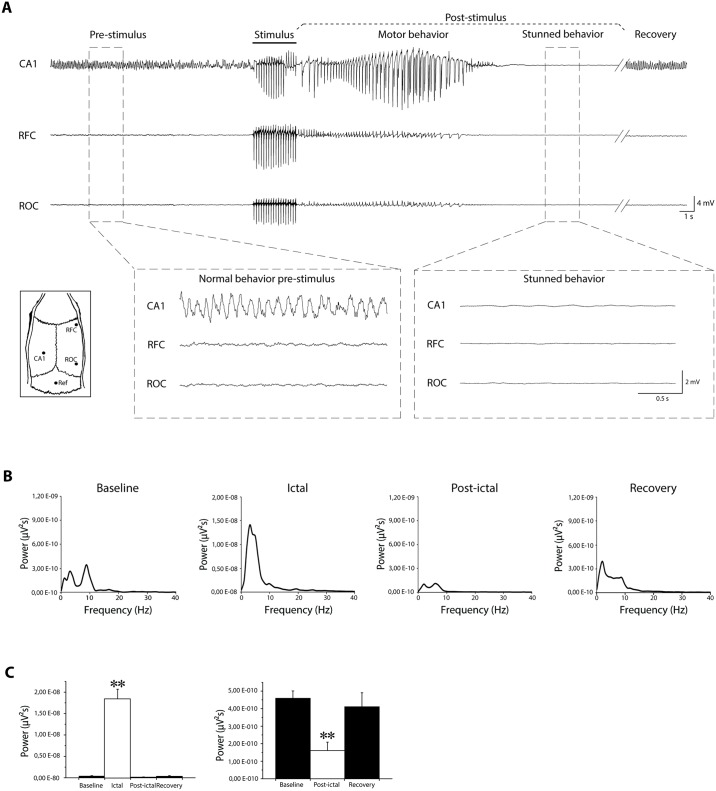
Video-electroencephalographic (EEG) recordings before and after 6-Hz corneal stimulation in mice.
(A) EEG traces obtained from frontal and occipital cortices, and hippocampal CA1 area before, during and after a corneal stimulation from one representative mouse. Pre-stimulus represents baseline activity. Black bar indicates stimulus artifact. In post-stimulation period, two major components are evident: ictal event followed by post-ictal depression characterized by flattening of basal activity (compare traces during post-ictal depression and baseline provided at higher magnification in insets). Small inset on the left shows electrodes position. (B) Mean power spectra obtained by fast Fourier transformation of traces recorded by epidural electrode in frontal cortex, during baseline (n = 6), ictal (n = 6), post-ictal (n = 6) and recovery (n = 5) phases. (C) Histogram on the left shows that power peak during ictal event is significantly greater that power peak during baseline, post-ictal and recovery phase (** = P<0.005; Mann-Whitney rank sum test). Histogram on the right shows that power peak during post-ictal depression is significantly lower than power peak during baseline and recovery (P<0.005; Mann-Whitney rank sum test). CA1: Cornu Ammonis 1 (depth electrode); Ref: reference electrode; RFC: right frontal cortex (epidural electrode); ROC: right occipital cortex (epidural electrode).